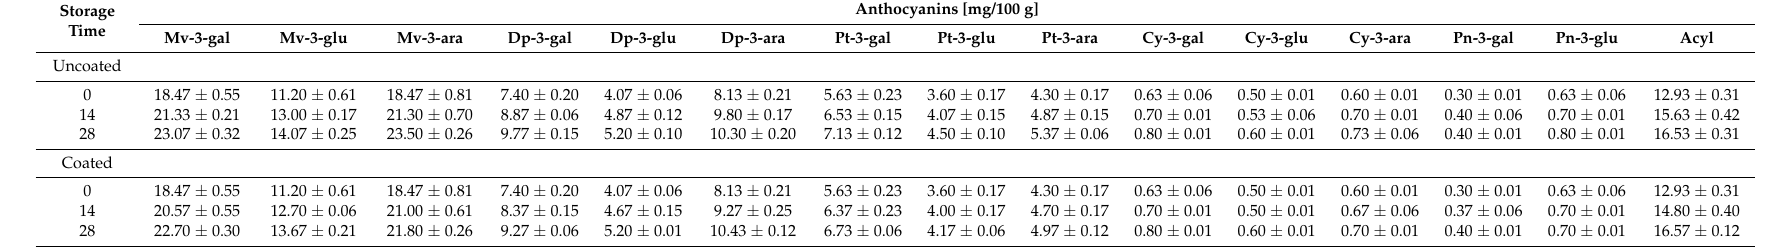
Table 5. Contents of anthocyanins in uncoated and coated blueberries fruit. Fruit were stored at 4 ◦ C for up to 28 days.